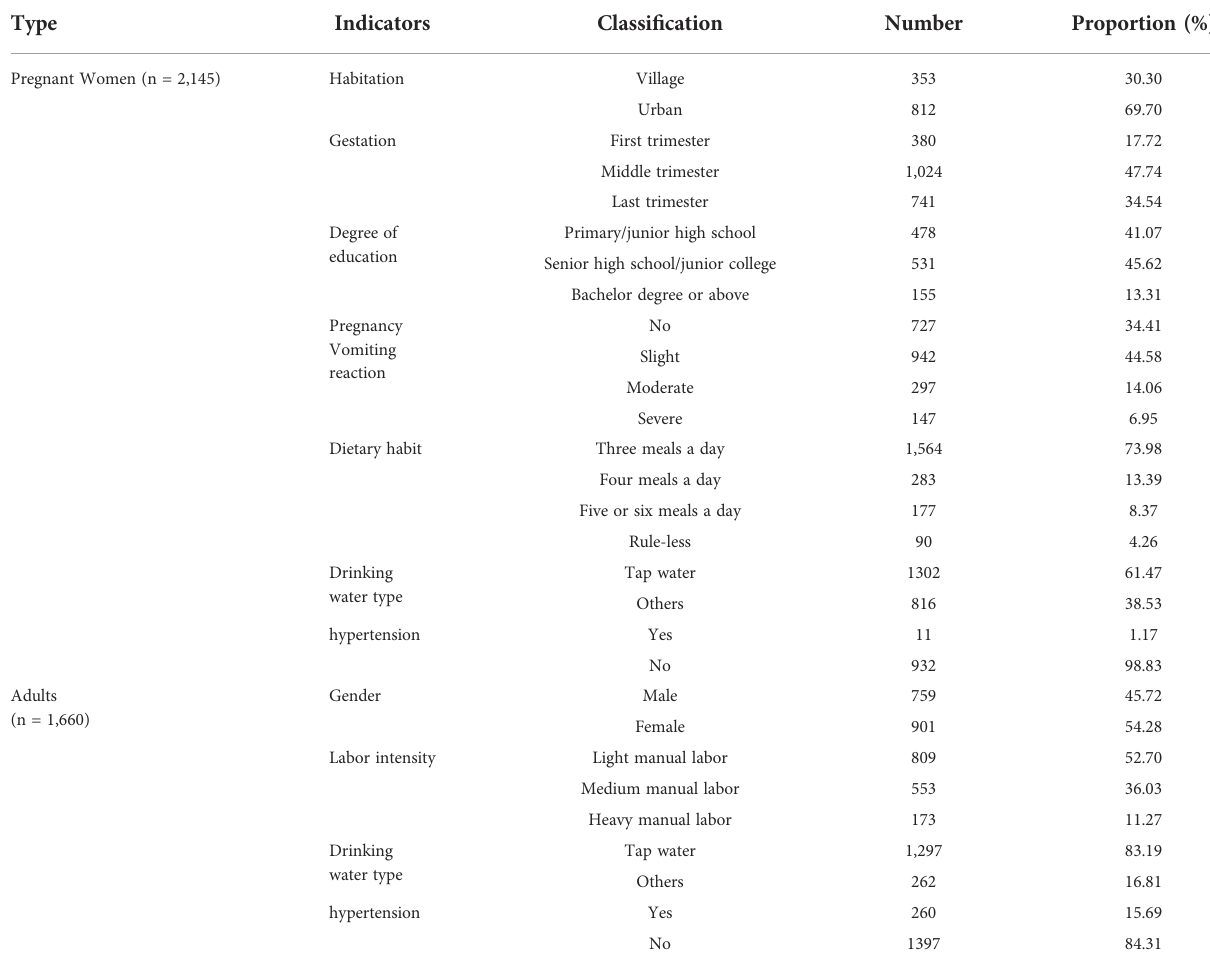
TABLE 1 Basic information of subjects in four